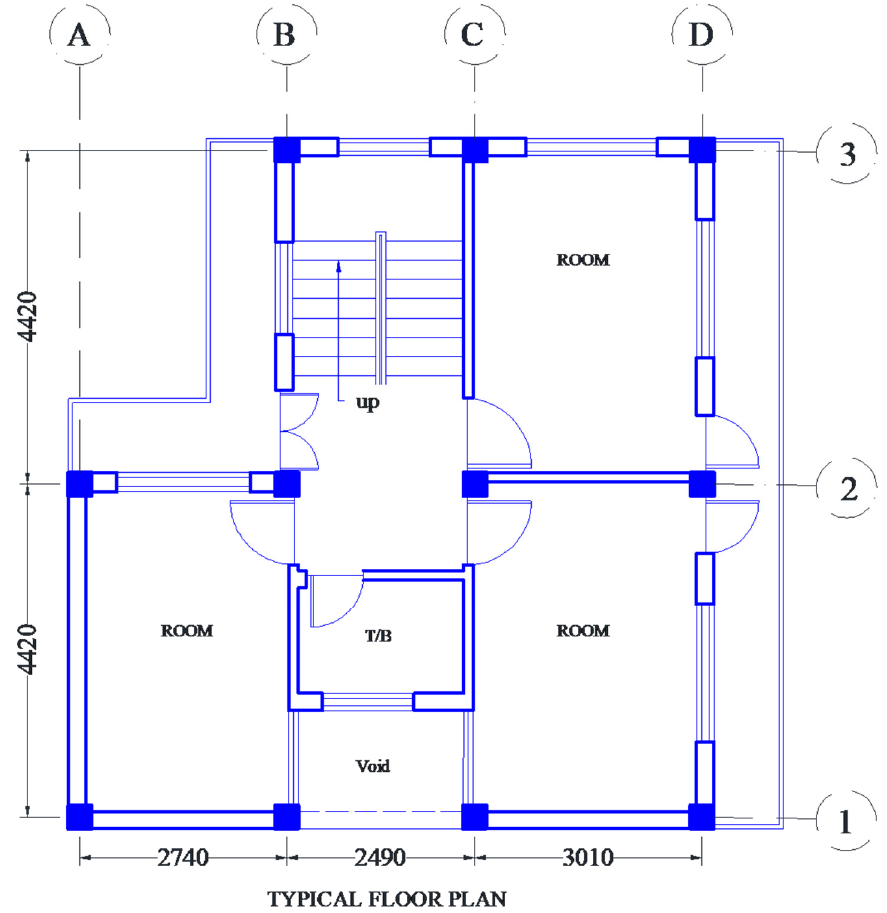
Figure 1. Typical floor plan of the case study building.